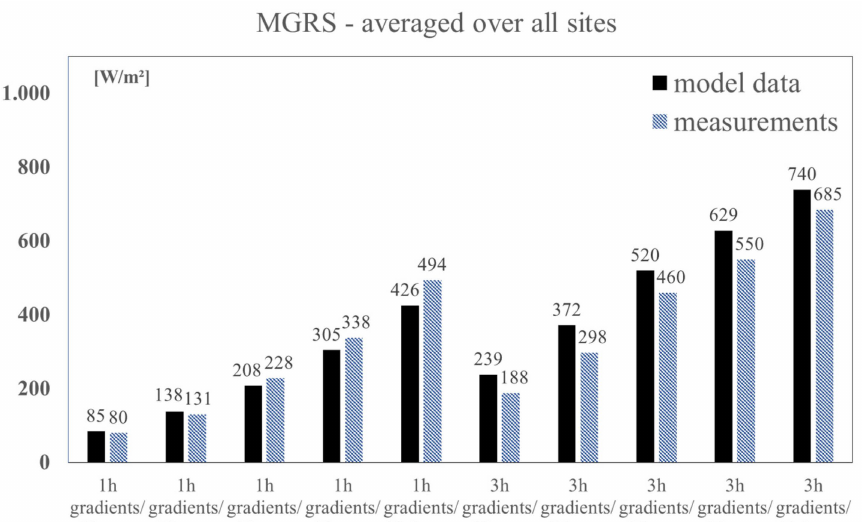
Figure 5. Maximum gradient of irradiation supply (MGRS) for different